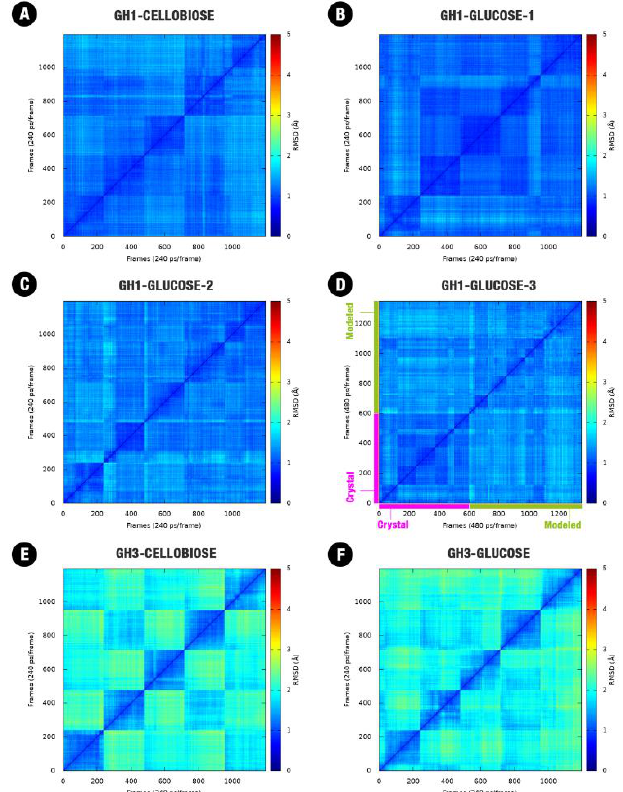
Figure 1. Two-dimensional root-mean-square deviation (RMSD) plot for the combined five trajectories (60 ns each one) for each one of the starting systems: ( A ) GH1 (HiBG)–Cellobiose complex, ( B ) GH1–glucose complex with glucose starting from the crystallographic pose, ( C ) GH1–glucose complex with glucose starting from the modeled pose, ( D ) GH1–glucose crystallographic complex (magenta) and the complex starting from the modeled pose (green). ( E ) GH3 (AaBG)–Cellobiose complex, ( F ) GH3–glucose complex. RMSD post the alignment of all the frames and considering just the backbone atoms (C α , C, O,